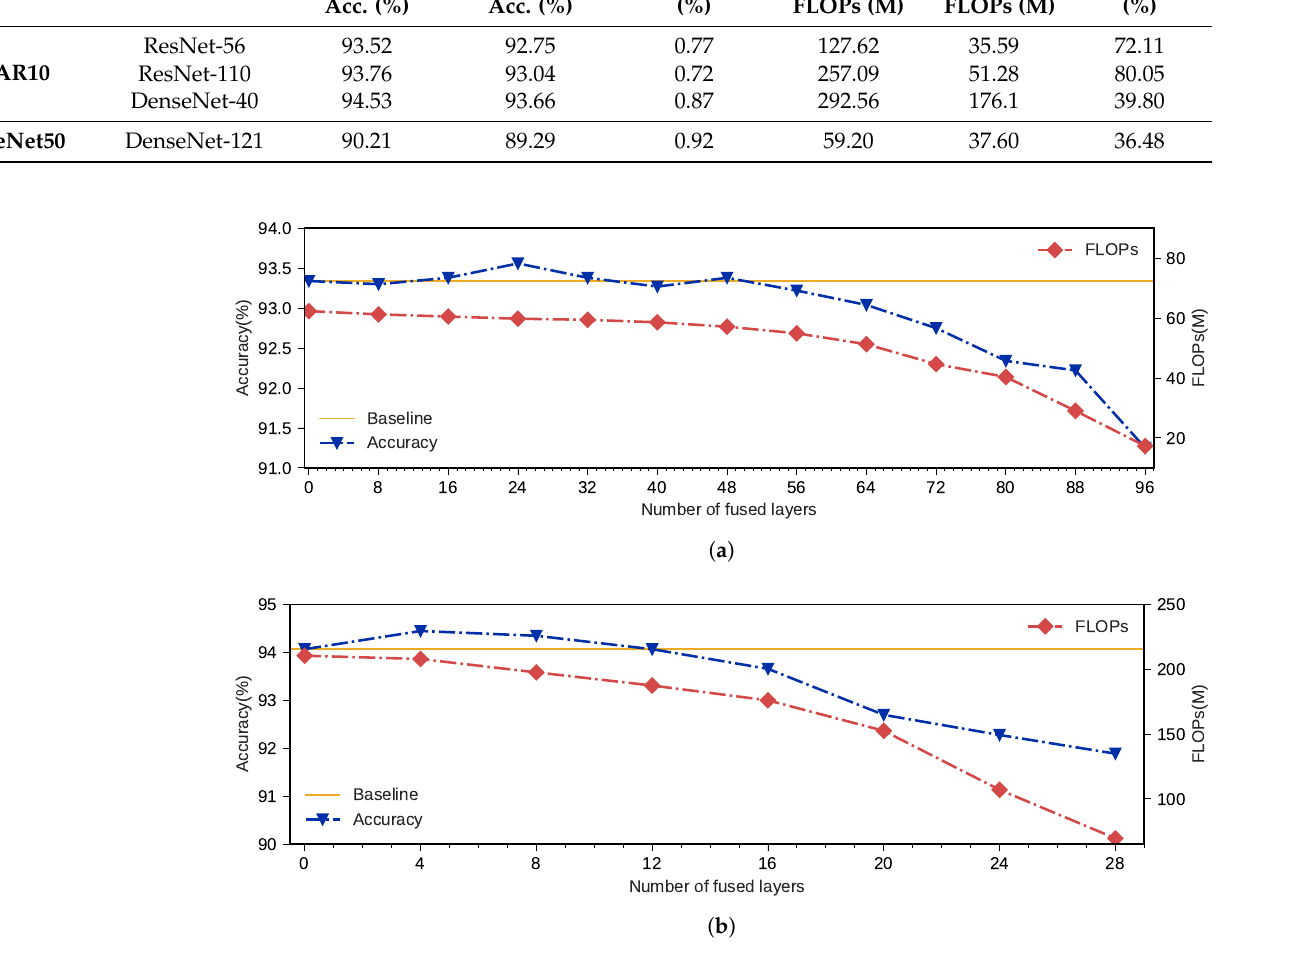
Figure 3. Layer fusion details of ResNet-110 and DenseNet-40. The accuracy and FLOPs of the model after all four layers are fused are shown in the figure. ( a ) ResNet-110. ( b )